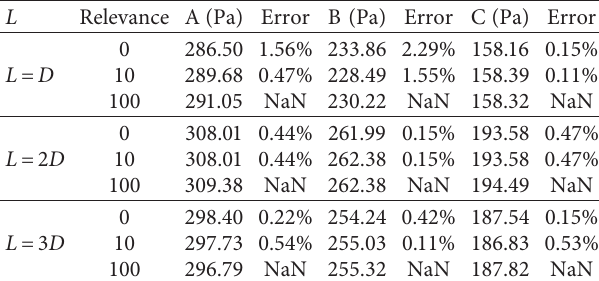
Figure 2: Mesh of “boundary layer” or prism layer drawn by Octree approach and mesh of enlarged vessel. Table 3: Results of Grid Independence Test